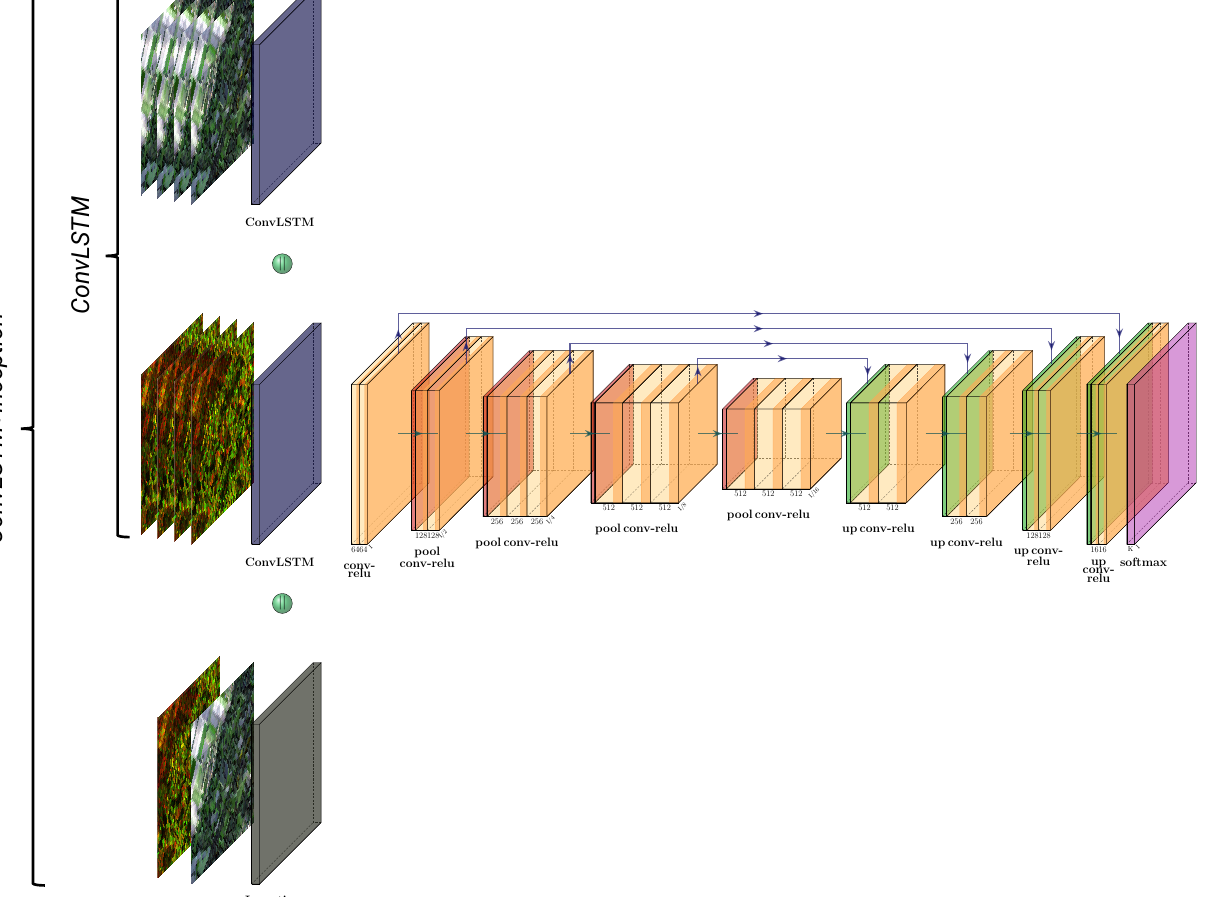
sign means concatenate). Incep- ||